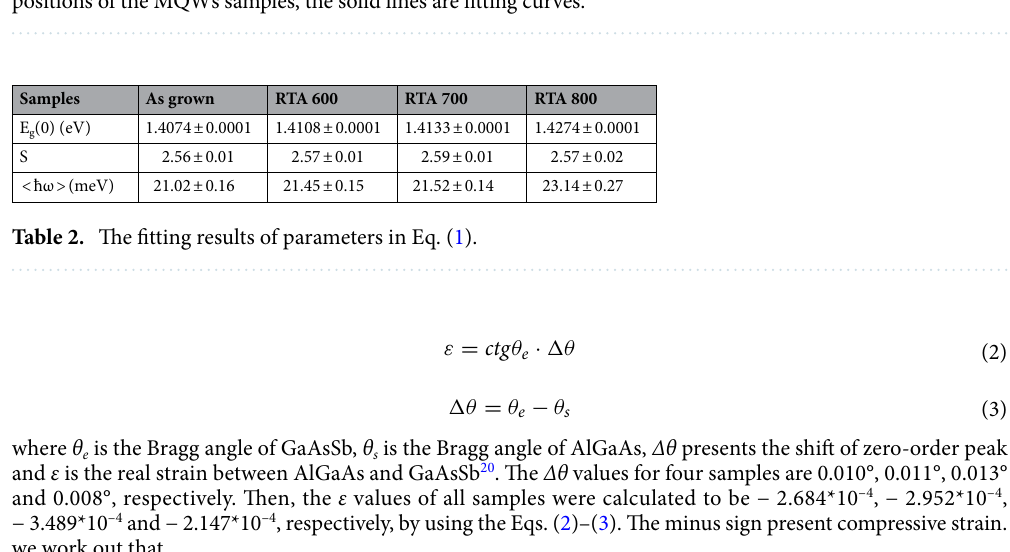
Figure 1. ( a ) Temperature dependent PL spectra of the GaAs 0.92 Sb 0.08 /Al 0.3 Ga 0.7 As MQWs under different annealed temperature: as grown, 600 °C, 700 °C, and 800 °C. ( b ) Temperature dependent emission peak positions of the MQWs samples, the solid lines are fitting curves.